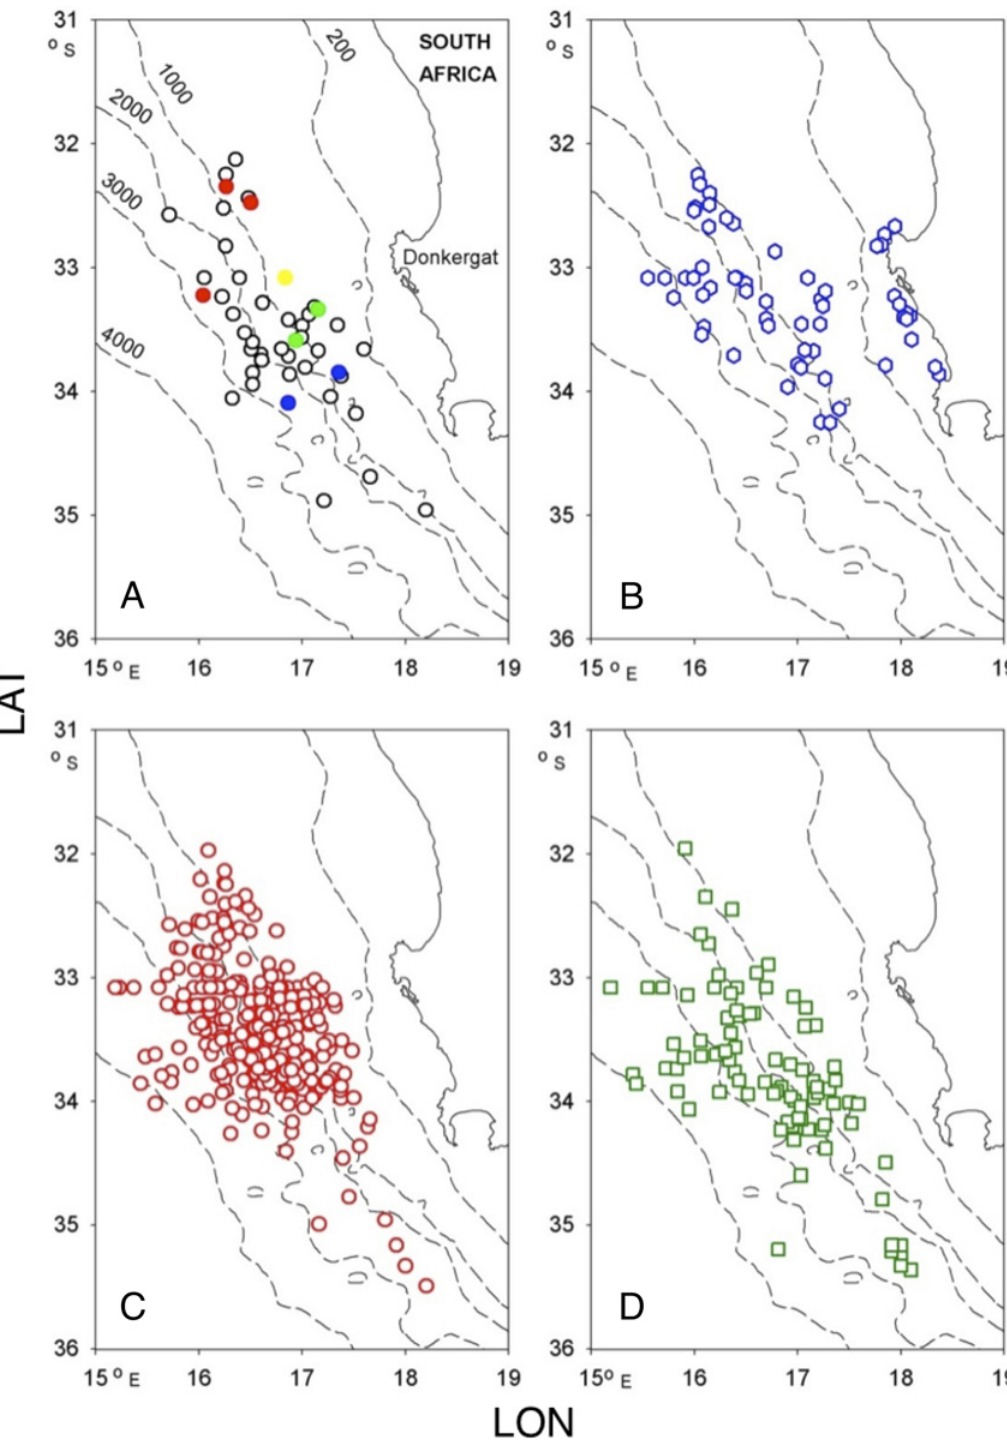
Fig 2. Whaling ground from Donkergat, South Africa, showing 1963 catch positions of A fin (black), blue (blue), humpback (red), minke (yellow) and killer whales (green); B Bryde ’ s whales; C sei whales and D sperm whales in relation to bathymetry (in m).